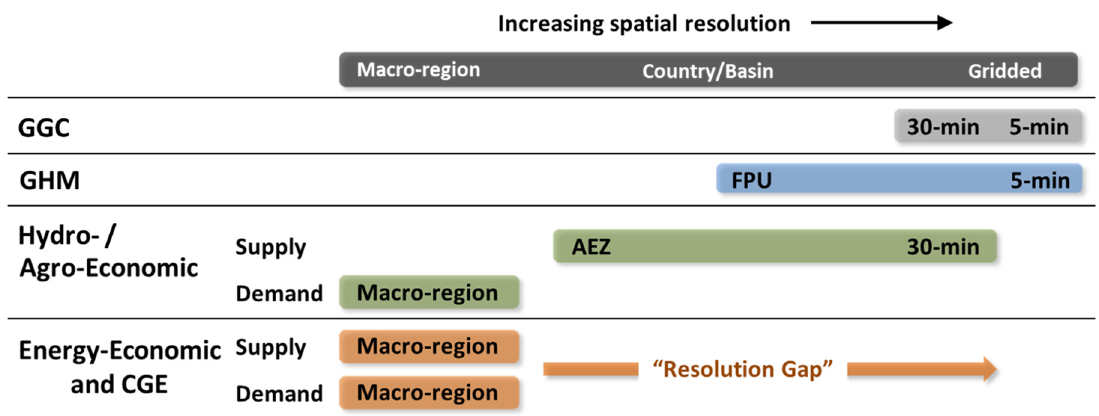
Figure 1. Range of spatial resolutions over which widely used global gridded crop models (GGCs,) GHMs, and economic models operate. Note that the resolution of supply decisions and commodity demands can differ within economic models. 30-min = 30-arcminutes, which is equivalent to 0.5 degrees; 5-min = 5-arcminutes, which is equivalent to 0.083 degrees; FPU = food production unit; AEZ = agro-ecological zone; CGE = computable general equilibrium.